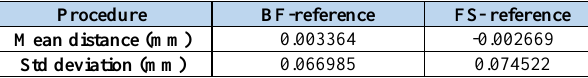
Table 3: Surface deviations of BF, FS 3D models in relation to the reference 3D